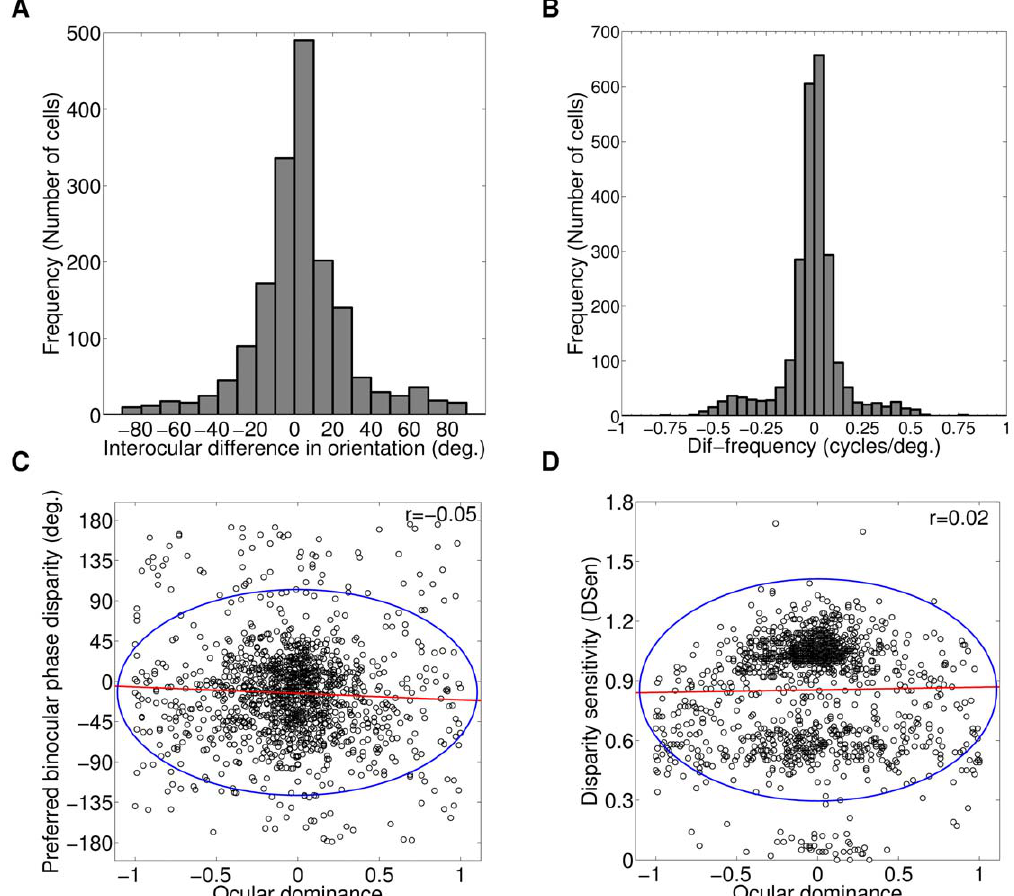
Figure 4. IDPO, Dif-frequency, OD versus DP, and OD versus DSen. (A) Histogram of interocular difference in preferred ORs. In our model cortex, 69.3% OR tuned cells (1200 out of total 1732) have IDPOs range of 6 20 u (S=9 u ). Rest 30.7% of cells have significant IDPOs ( . + 20 0 j j ). (B) Histogram of Dif-frequency cells in cycles/degree. In our model cortex, 50.44% of cortical cells (1261 out of total 2500) have Dif-frequency range of 6 0.05 cycles/degree. In remaining 1239 cells, 1179 (47.16%) cells have significant Dif-frequency ( . + 0 : 05 j j 0.05 cycles/degree) and 60 (2.4%) cells are OR untuned in both eyes or have very weak responses from which we were not able to determined there SFs in left and right eyes. (C) Scatter plot of preferred binocular phase disparity (in 2 180 u to + 180 u scale) and OD for all OR tuned cells. The plot shows almost no correlation (r=-0.05) between them at cell population level. (D) Scatter plot of disparity sensitivity (or selectivity) and OD for all OR tuned cells. The plot shows almost no correlation (r=0.02) between them at cell population level. The red line represents the linear regression line and blue ellipse indicates 95% prediction interval in ‘B’ and